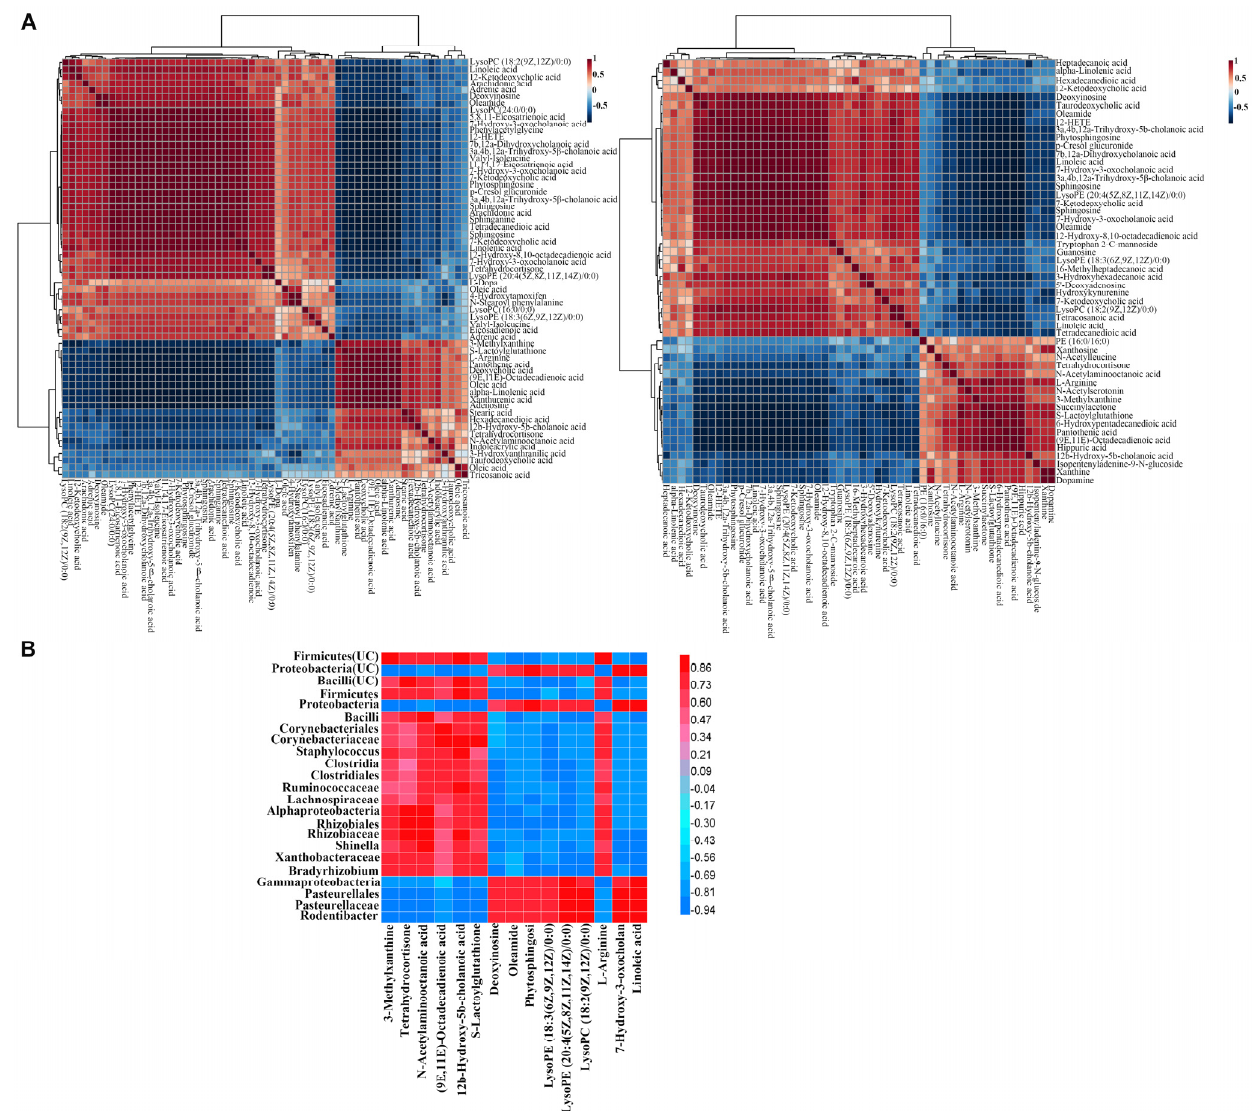
Figure 4. ( A ) Analysis of the biomarker − to − biomarker correlations in different samples. ( B ) Corre- lation plot showing the functional correlation between the pulmonary microflora and metabolites.